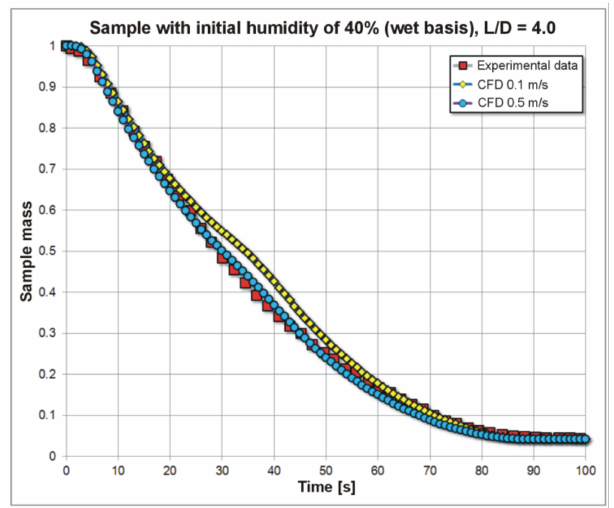
Figure 6. Comparison between simulated and experimental results [2] for pyrolysis of sample with 40% initial moisture (determined on wet basis) and L/D = 4—2D/3D